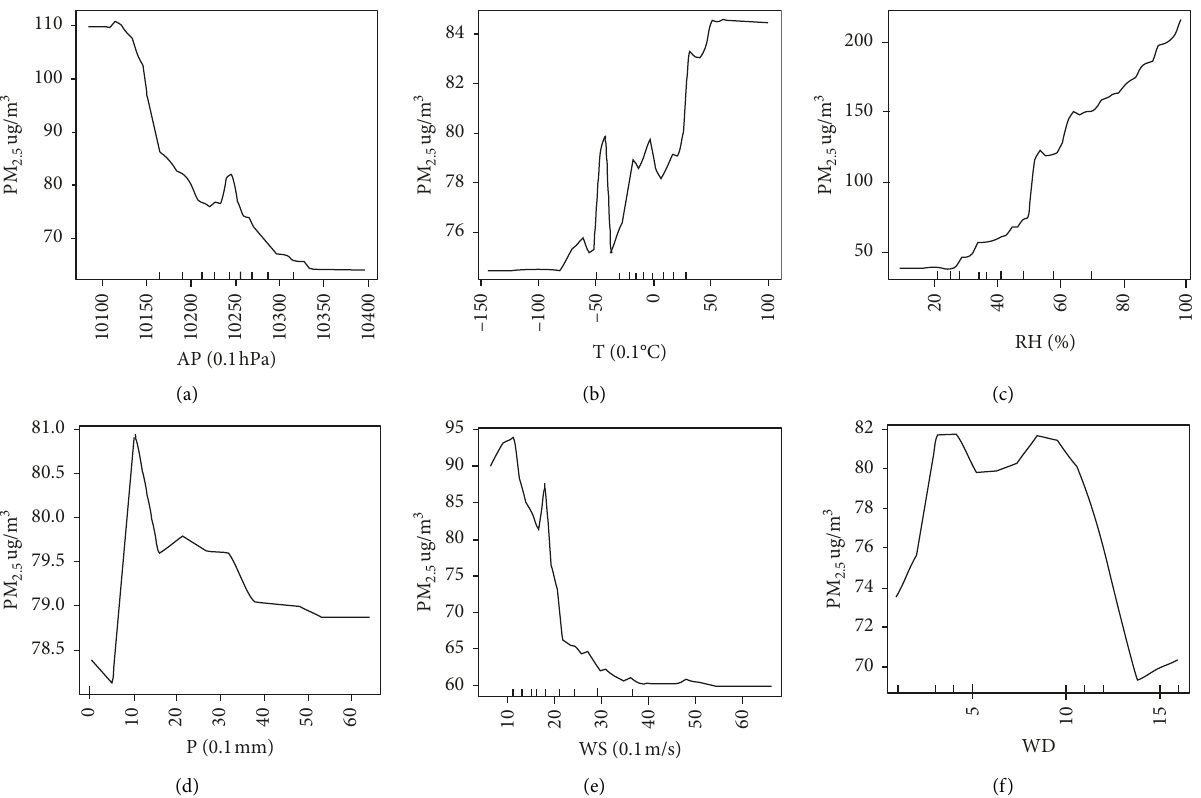
Figure 3: Partial dependence plots between meteorological factors and PM